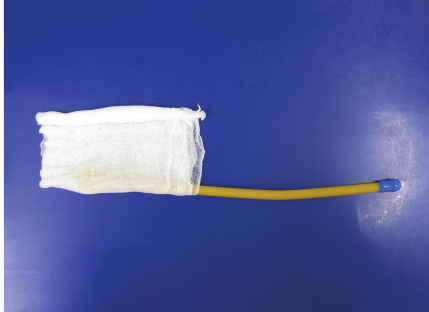
Figure 2: The gauze is further folded in half around the catheter and rolled up from the opposite side toward the